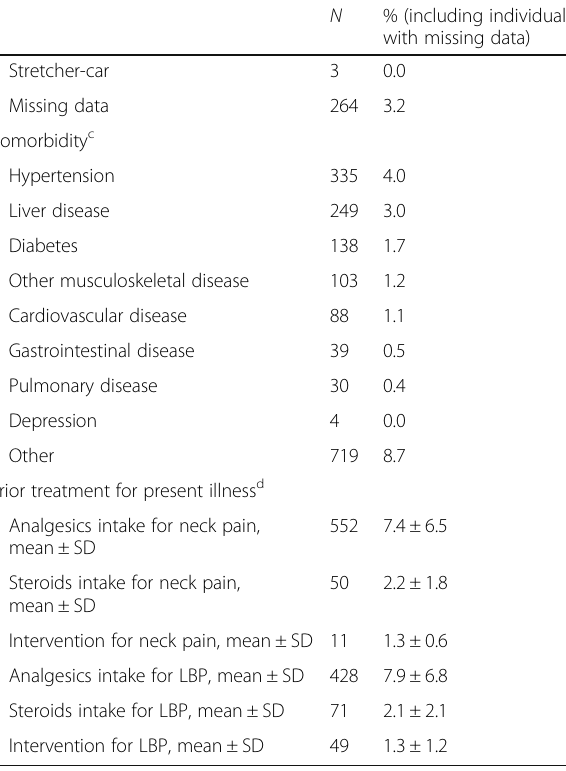
Table 1 Sociodemographic characteristics, medical comorbidities, and prior treatment for current symptoms